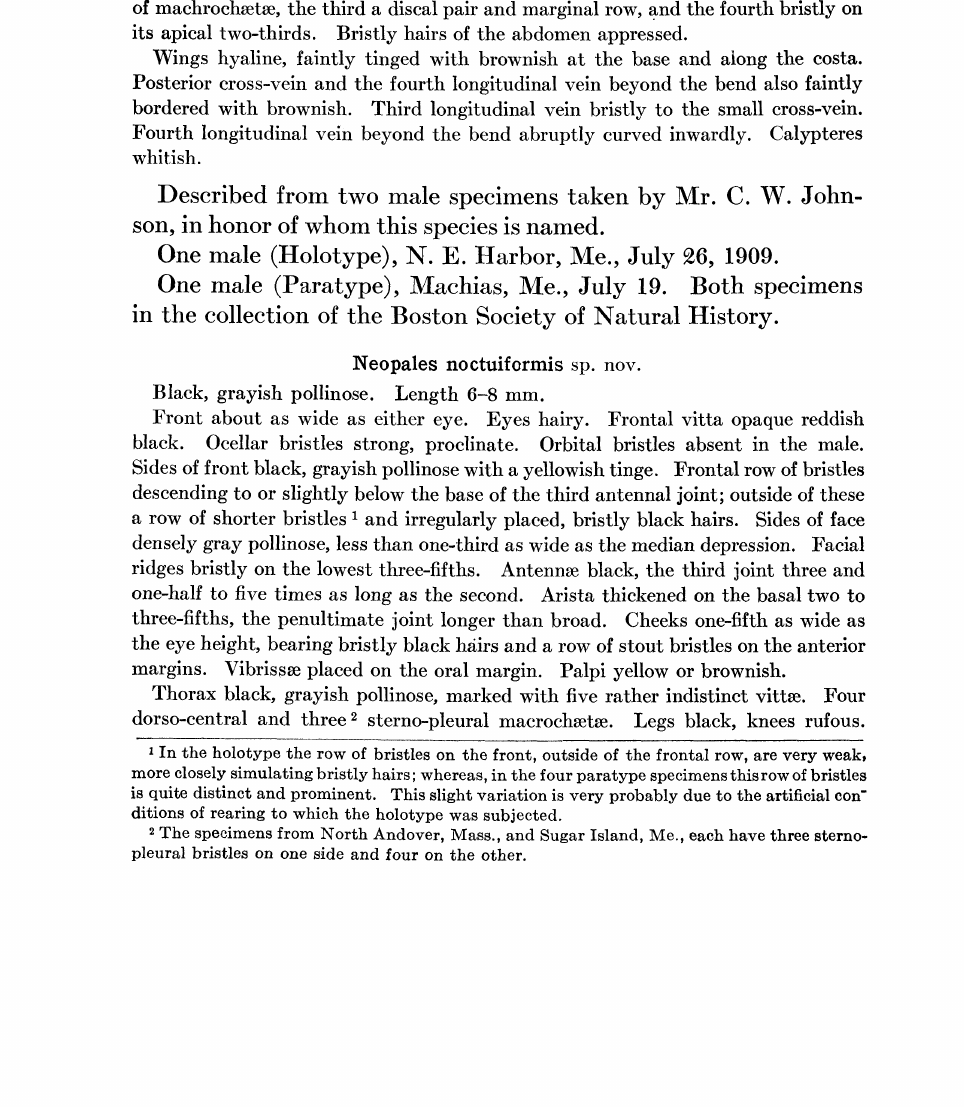
Thorax shining black, grayish pollinose, with a bronzy tinge, marked with three black vittm. Three dorso-central and three sterno-pleural macrochmtm. Scutellum black, bearing three pairs of marginal macrochmte, the apical pair cruciate. Bristles of scutellar disk, erect. Abdomen shining black, grayish pollinose on the basal margins of the three pos- terior segments. The second segment bearing a median discal and marginal pair of machrochete, the third a discal pair and marginal row, and the fourth bristly on its apical two-thirds. Bristly hairs of the abdomen appressed. Wings hyaline, faintly tinged with brownish at the base and along the costa. Posterior cross-vein and the fourth longitudinal vein beyond the bend also faintly bordered with brownish. Third longitudinal vein bristly to the small cross-vein. Fourth longitudinal vein beyond the bend abruptly curved inwardly. Calypteres